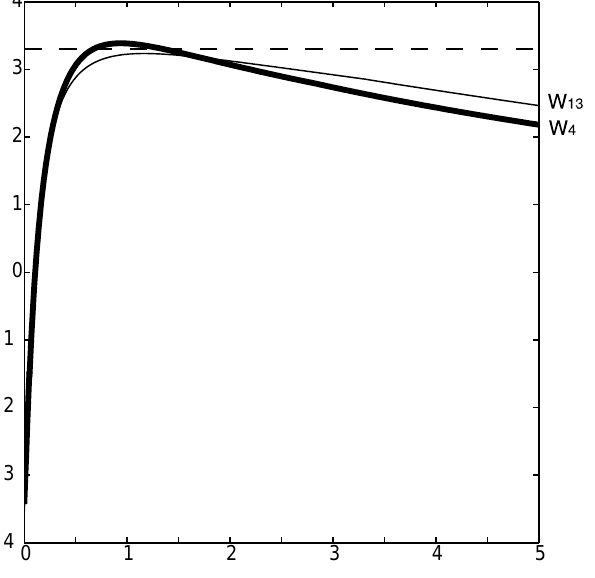
Fig. 4. Trajectories of single charged ions in the A16 detector plane ( 8 h = − 4V and 8 s = + 4V) for different arrival ener- gies: 8.01eV (solid line), 7.67eV (dashed line) and 7.33eV (dash- dot line) and different arrival windows: w 1 ,w 4 ,w 7 ,w 10 ,w 13 , and w 16